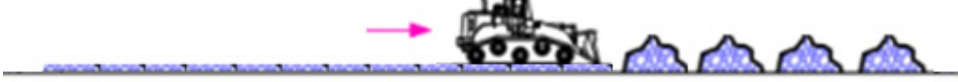
Figure 13. Filtered Tailings Drying Operation–Construction Method